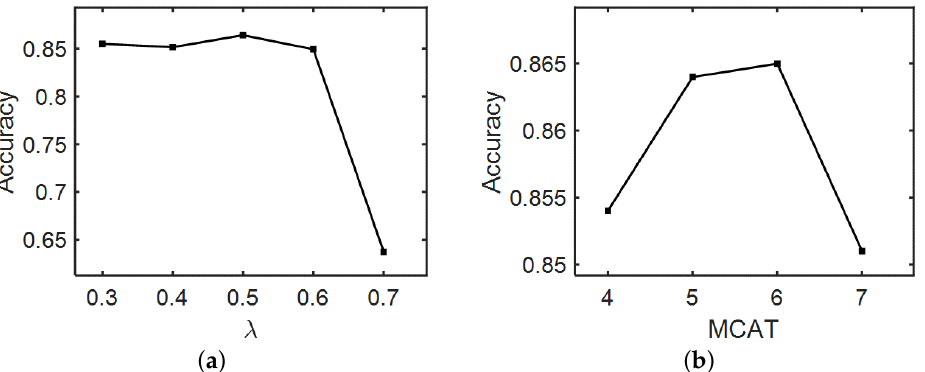
Figure 3. Performance of CM-NET under different parameters. ( a ) The impact of different λ . ( b ) The impact of MCAT with different